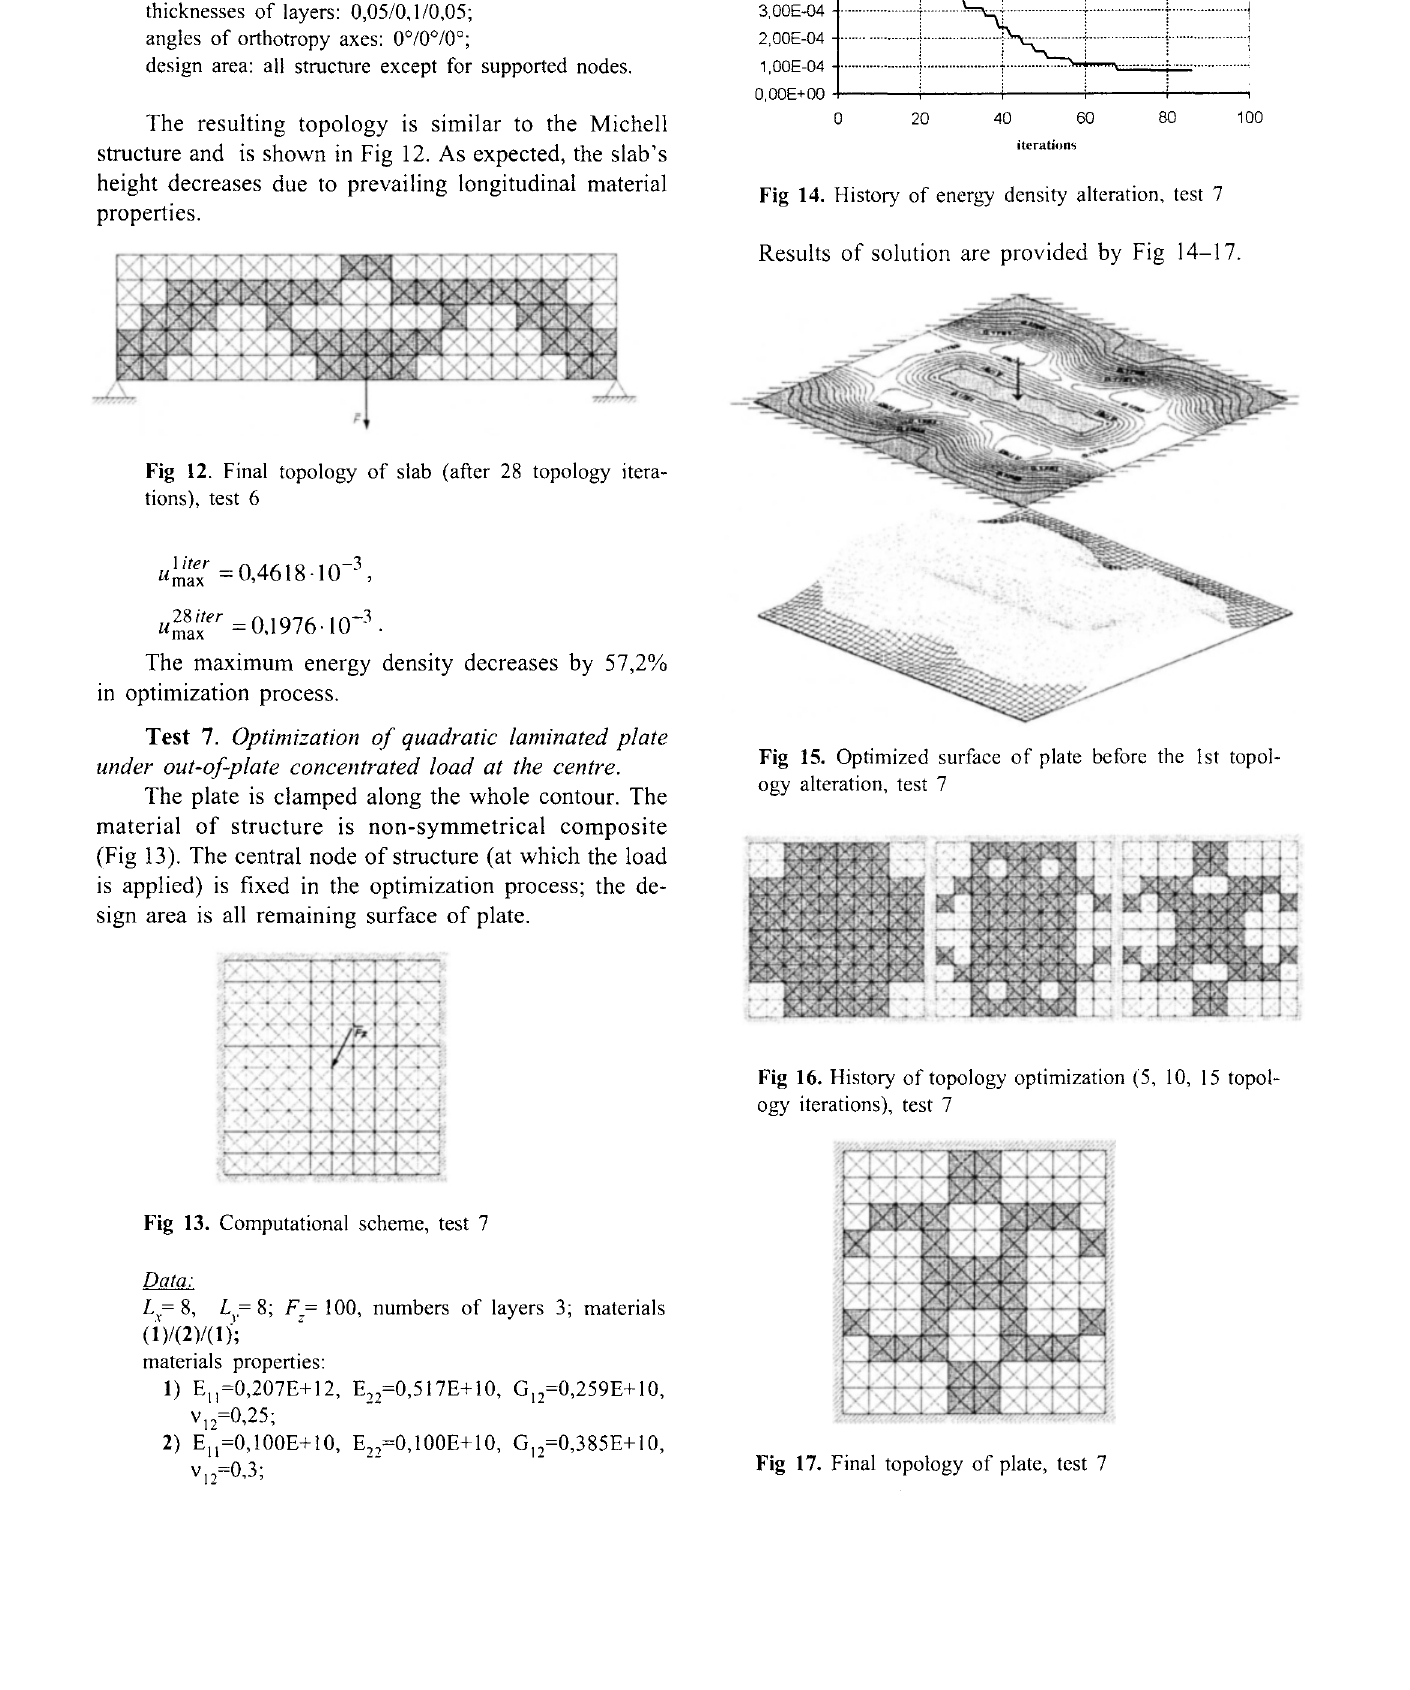
Fig 17. Final topology of plate, test